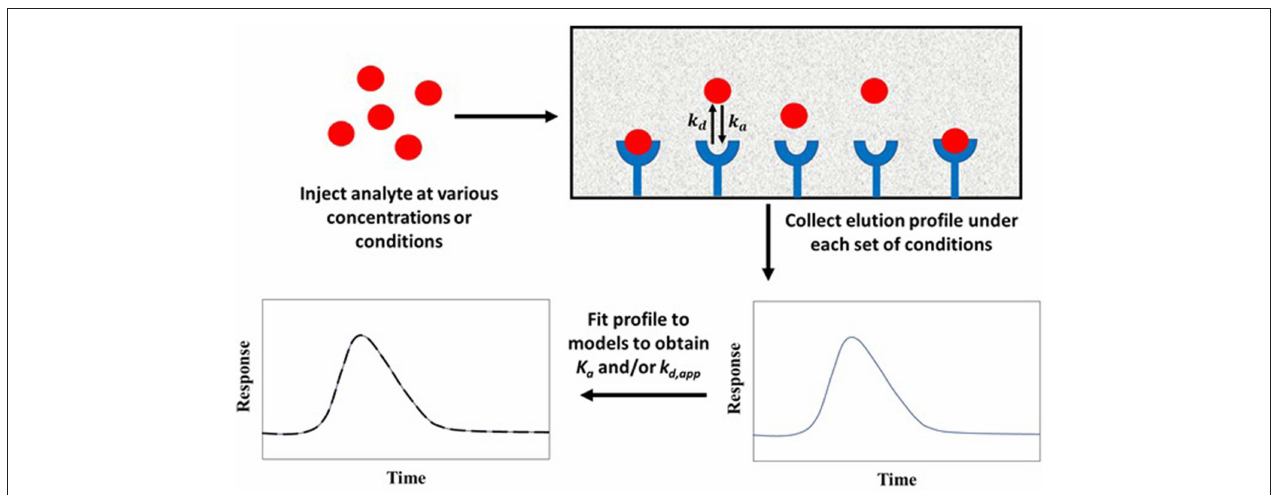
FIGURE 10 | General scheme for studying analyte interactions with an immobilized binding agent by peak fitting. Terms: K a , association equilibrium constant; k a , association rate constant; k d , dissociation rate constant; k d , app , apparent dissociation rate